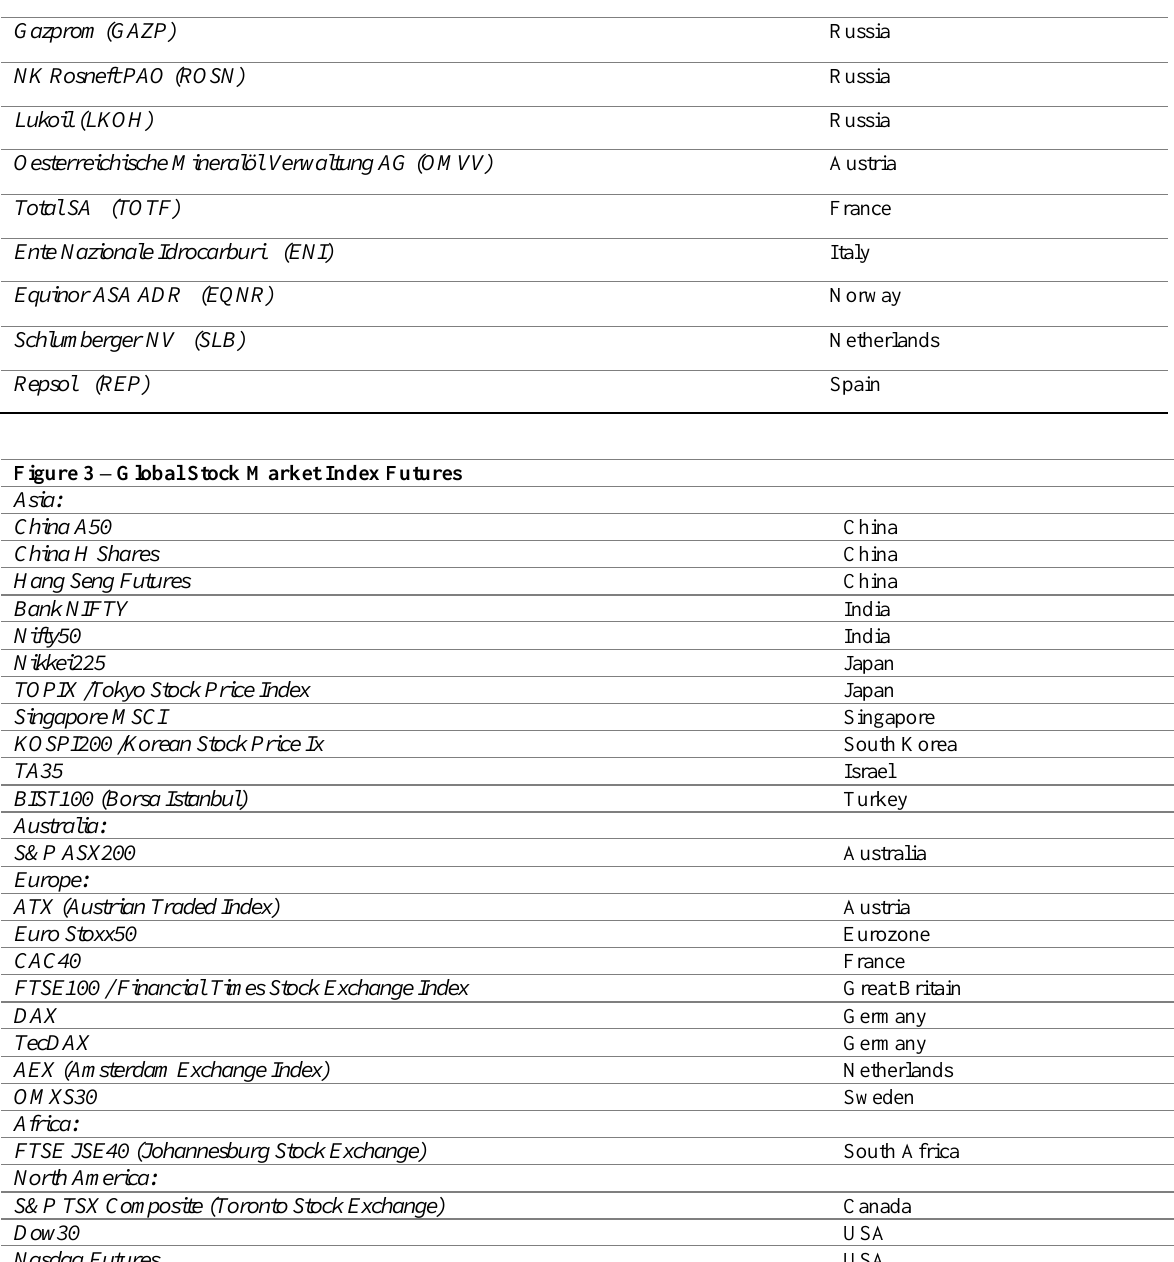
Figure 1 – Energy Sector: Crude Oil Stock Companies